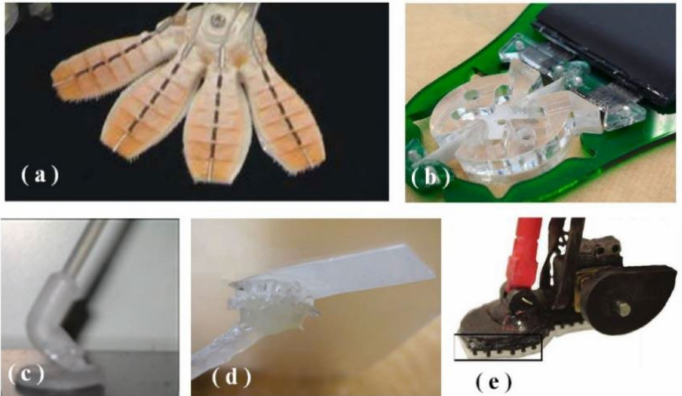
Figure 1. Several representative dry sticking wall robotic feet designs: ( a ) The foot of Stickybot; ( b ) the foot of Stickybot-III; ( c ) the foot of Abigaille; ( d ) the foot of Abigaille-II; ( e ) the foot of